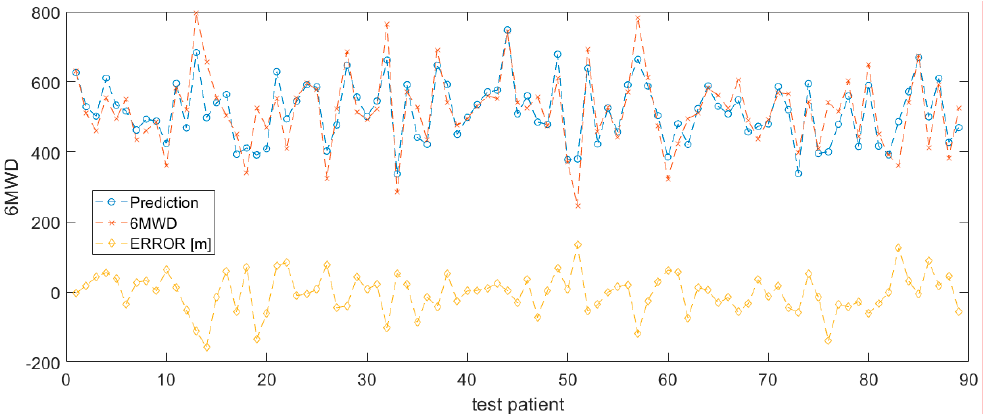
Figure 2. 6MWD prediction based on accelerometer derived effort and chronotropic response.